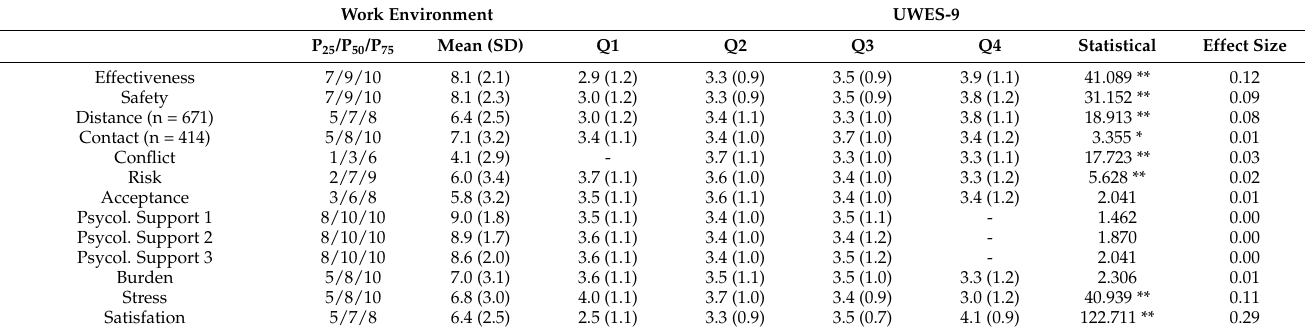
Table 3. UWES-9 score related to the work environment (N = 1085).